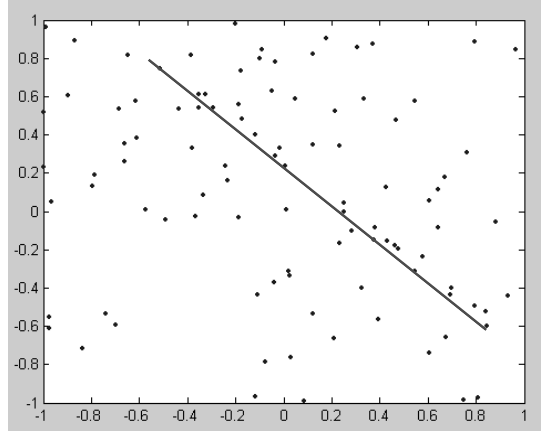
Fig 5. Detected line: true values φ = 0,8; s = 0,2; σ = 0,02